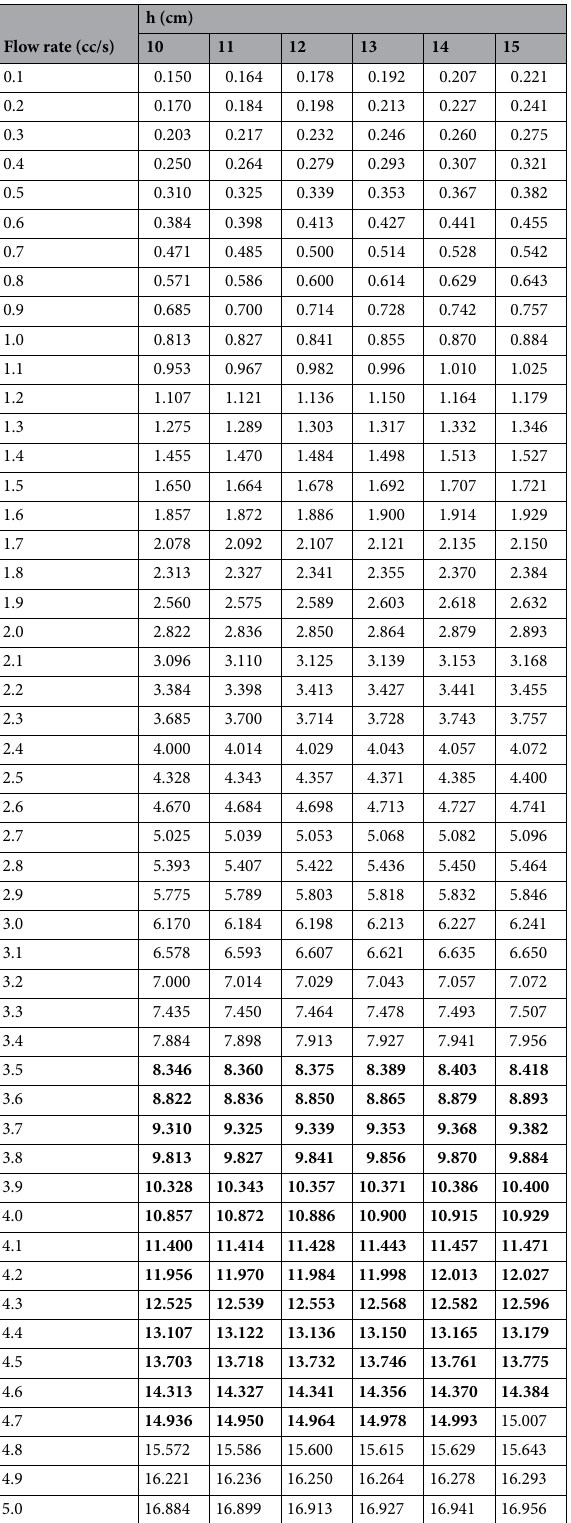
Table 1. Flow rate analysis according to the height from the wound of 19 gauge. Significant values are in